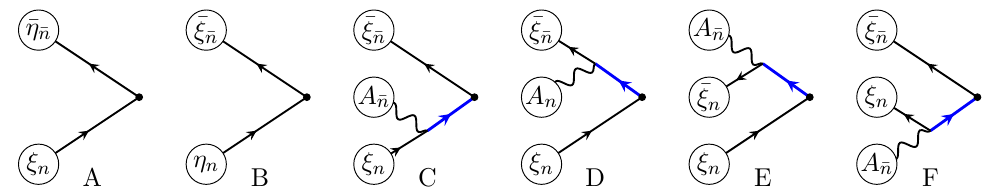
Figure 4 . The diagrams contributing to the tree order of vector current at NLP. The diagrams with n ↔ ¯ n should be added. The blobs indicate the type of background field. The blue lines are the dynamical